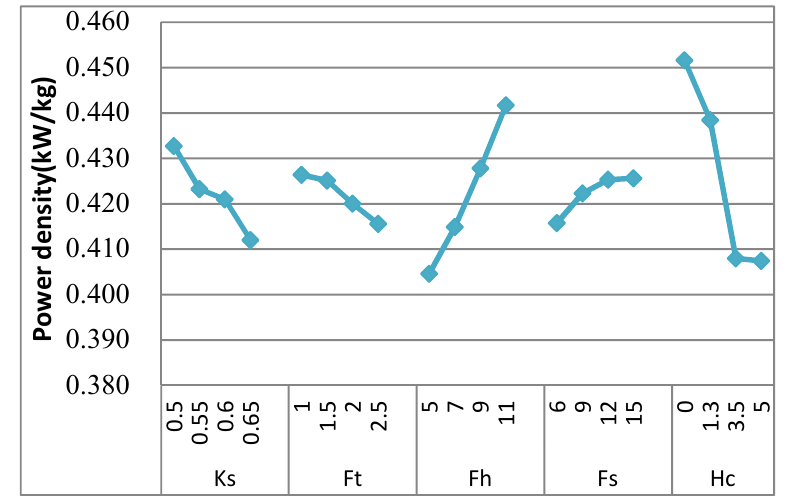
Figure 6. The effect of the main factors on the power weight ratio.